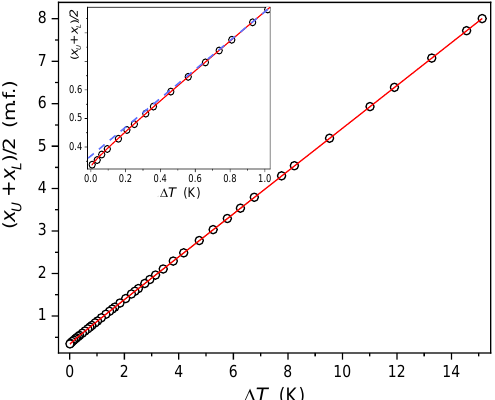
Figure 6. The diameter of the Liquid-Liquid coexistence curve (binodal, TP2 domain), based on data from Figure 1. The inset focuses on the immediate vicinity of the critical consolute temperature ( T C = 276.12 K). The solid curve (in red) is related to the portrayal via ‘the critical’ Equation (3). The dashed (blue) line is for extrapolated linear changes, which can portray the behavior for |𝑇 𝐶 − 𝑇| > 0.6𝐾 . The results presented reveal the following sequence: